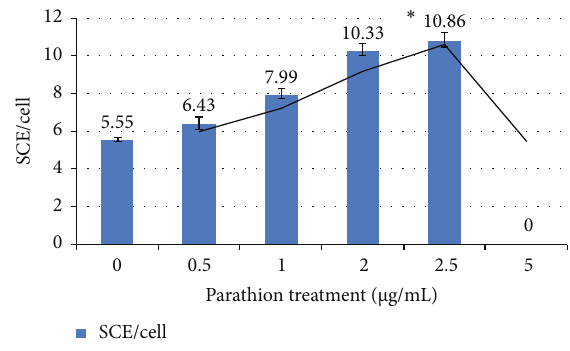
Figure 2: Induction of SCE in cultured lymphocytes by parathion. ∗ 𝑃 < 0.05 (significance as compared to untreated).